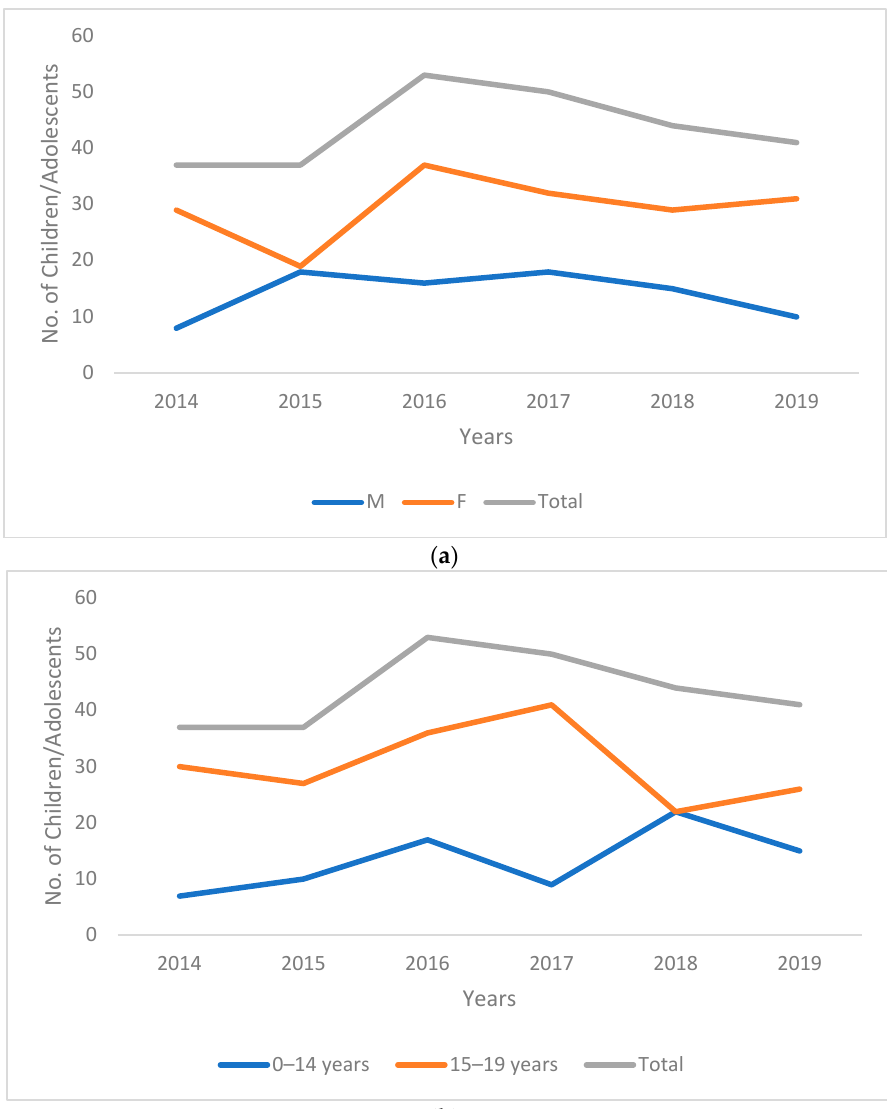
had pulmonary TB. The resistance pattern observed in this cohort is detailed in Table 1. in 2016. More female patients were enrolled each year as compared to males with the Most patients had RR/MDR-TB ( n = 198; 75.6%). male-to-female ratio ranging from 0.28 to 0.95 (highest in 2015).